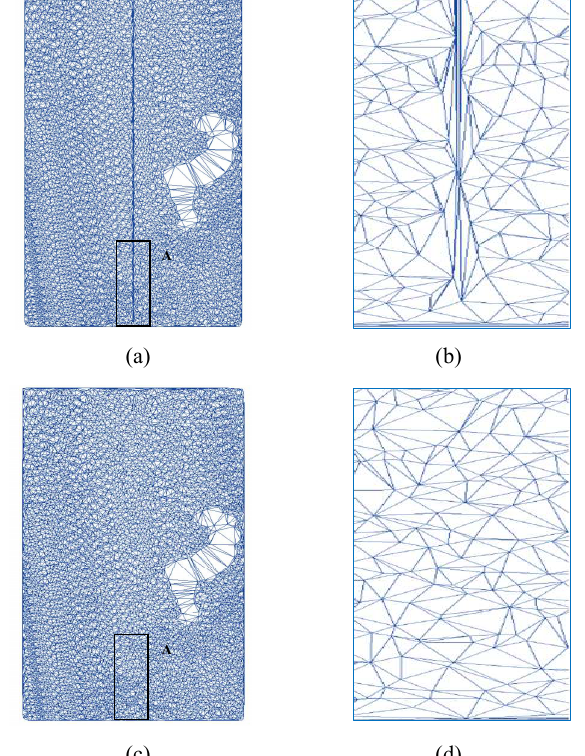
Figure 5. Delaunay triangulation construction of a small size of point cloud in the experimental area: